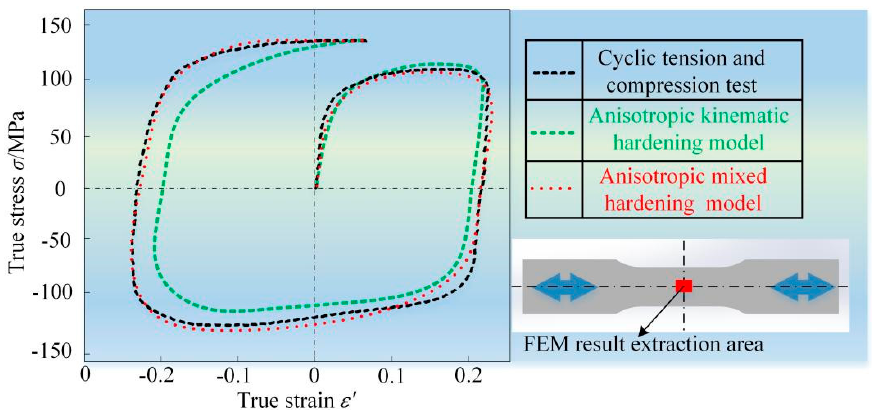
Figure 11. Fitting and calibration of constitutive elastic–plastic material model parameters and comparison of simulation and experimental results.